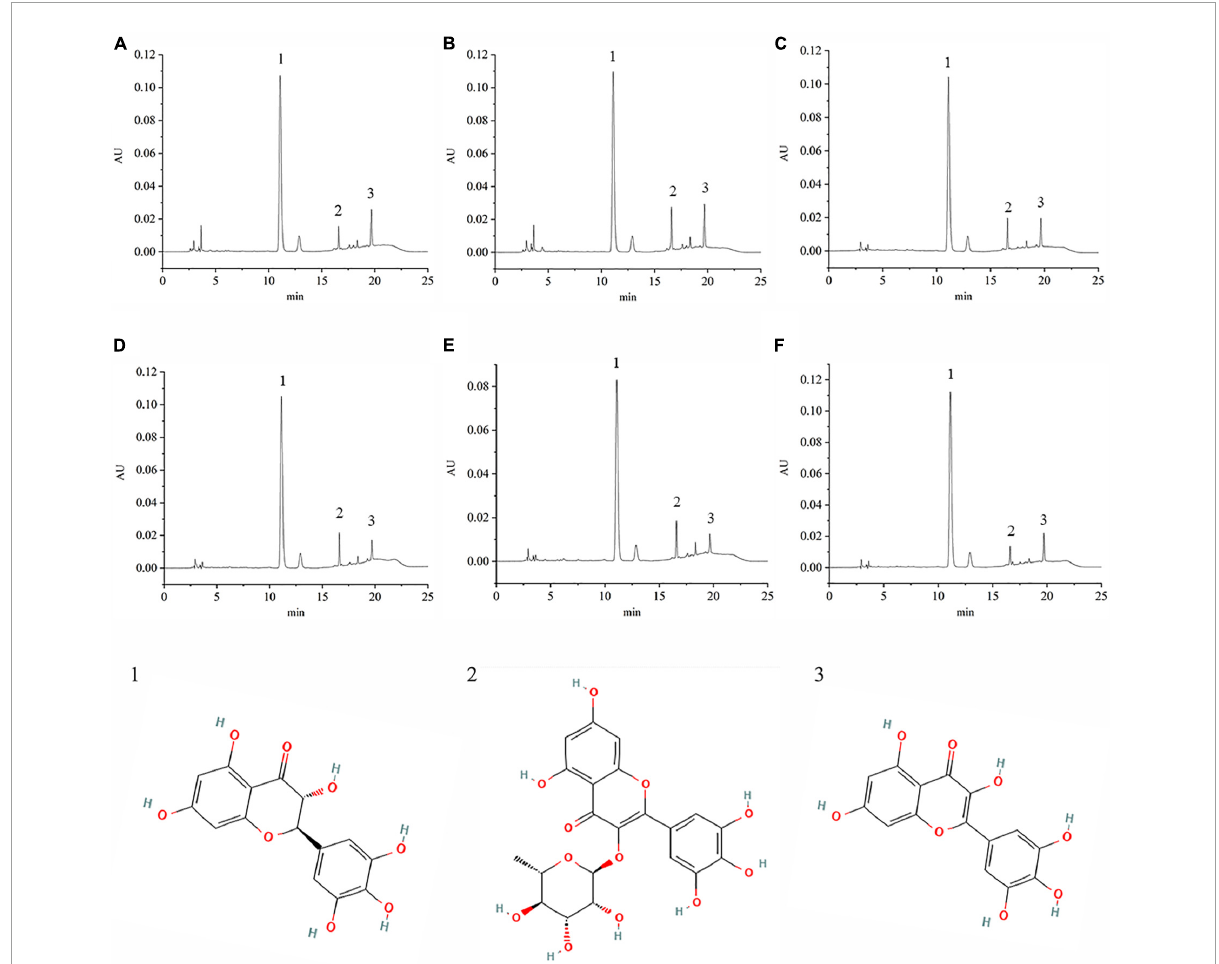
FIGURE1 The chromatography of different vine teas. (A) Wild vine tea in Enshi, Hubei. (B) Hubei Enshi selenium-rich vine tea. (C) Guangzhou Qingyuan (Level 1). (D) Guangzhou Qingyuan (Level 2). (E) Wild vine tea in Shiqian, Guizhou. (F) Wild vine tea in Zhangjiajie, Hunan; 1, Dihydromyricetin; 2, Myricitrin; 3,